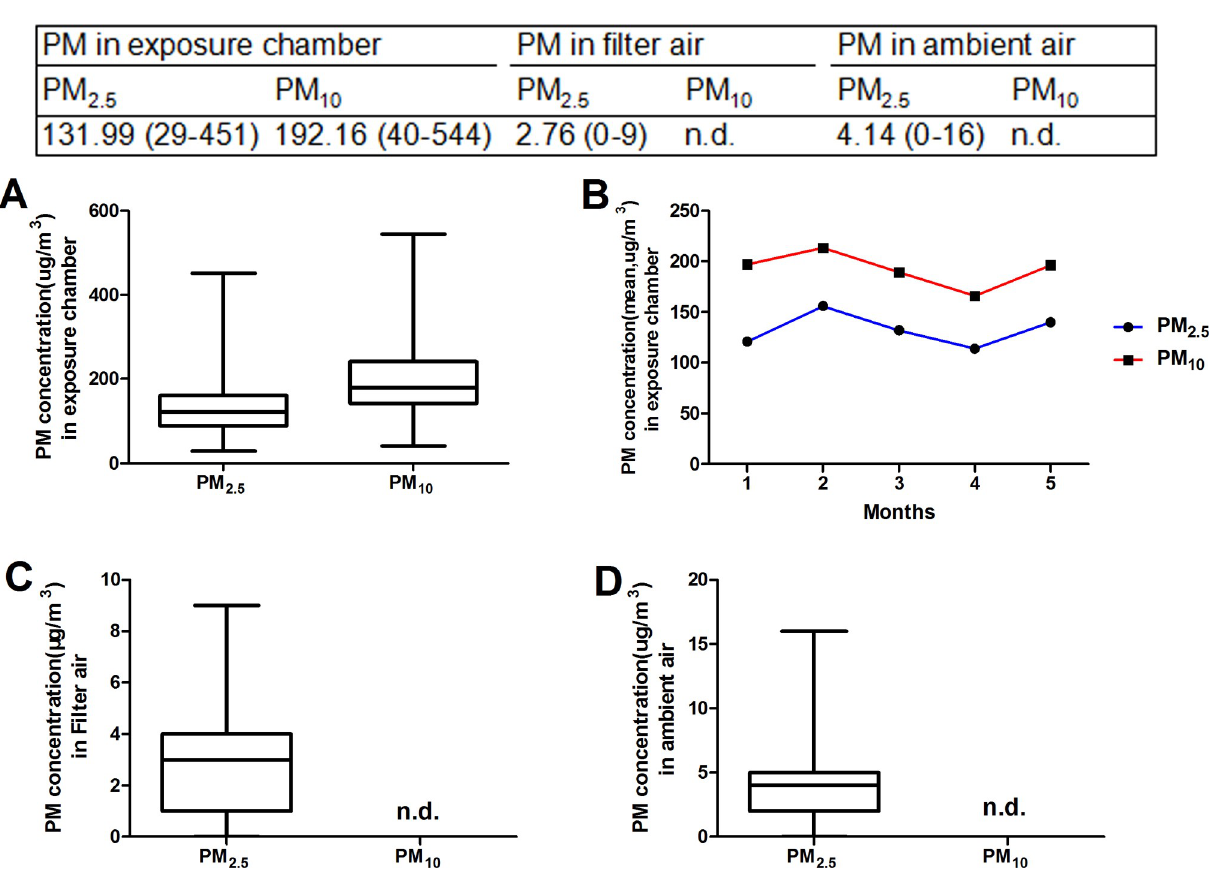
Fig 1. The concentration of PM 2.5 and PM 10 in different chambers (Median). (A) PM 2.5 and PM 10 in the exposure chamber. (B) The average concentration of PM in the exposure chamber. (C) PM 2.5 and PM 10 in the filter air. (D) PM 2.5 and PM 10 in the ambient air. n.d.: not